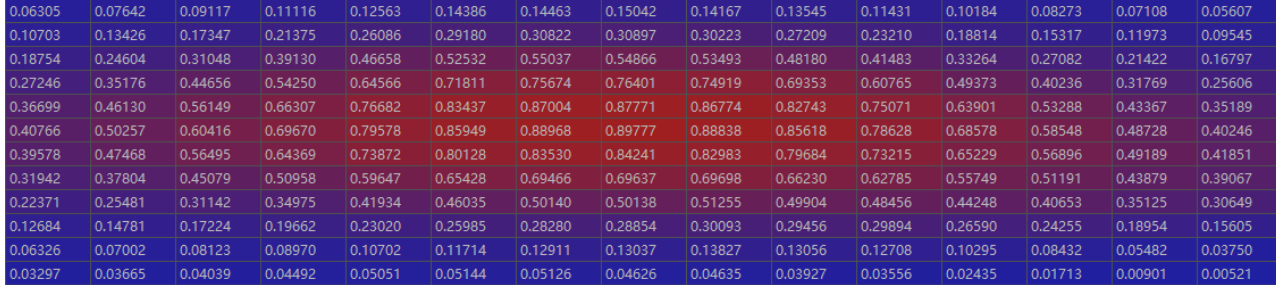
Figure 6. ConfMap diagram of a single pedestrian. The value for each grid in the figure corresponds to the probability that the target is a pedestrian. Because the channel where the pedestrian is located corresponds to the first channel in three-primary colors (RGB), the higher the probability value, the deeper the corresponding grid red.